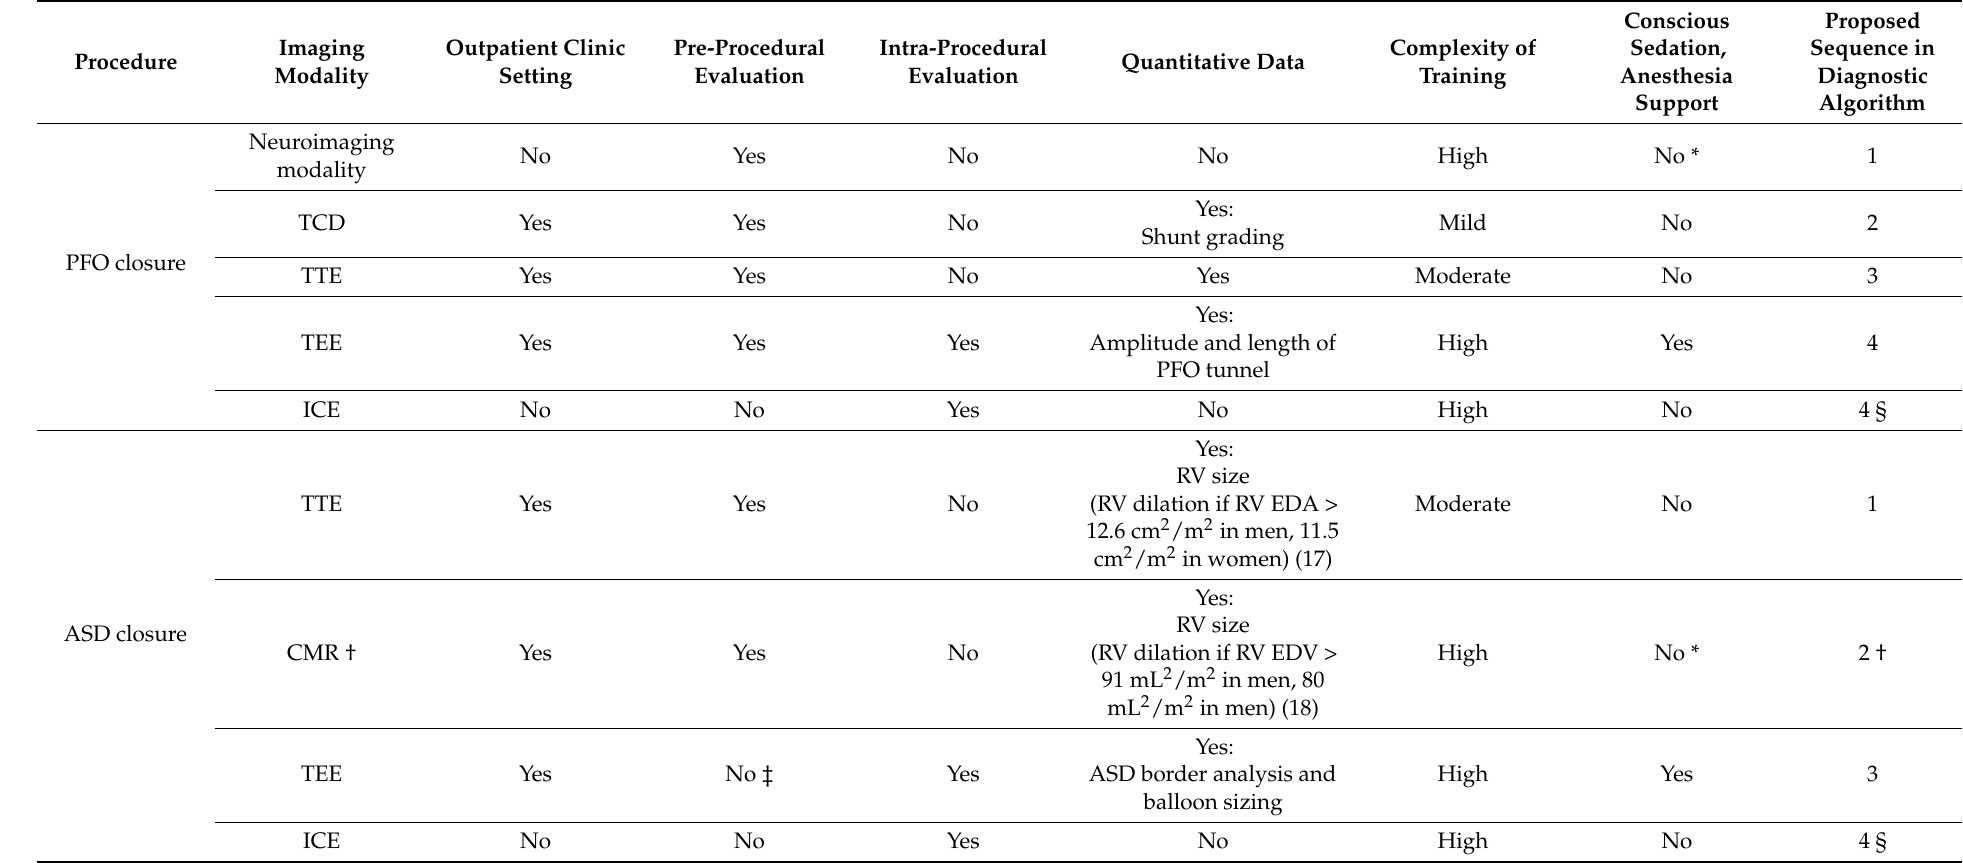
Table 2. Comparison of different imaging modalities for PFO and ASD transcatheter